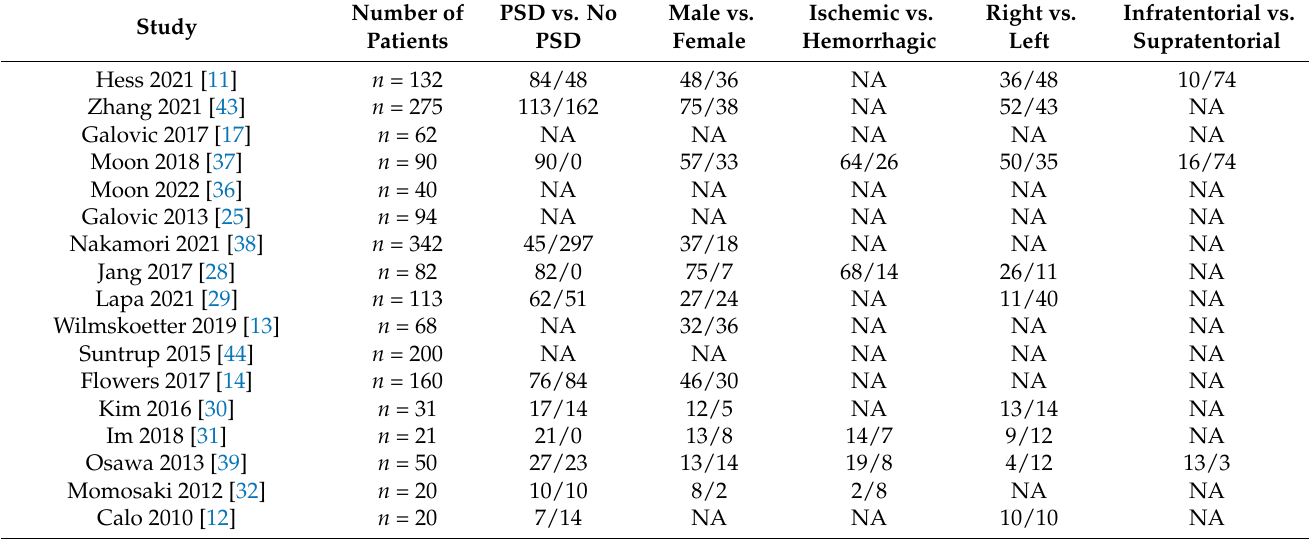
Table 4. The incidence of PSD stratified by gender, type of stroke, and location of